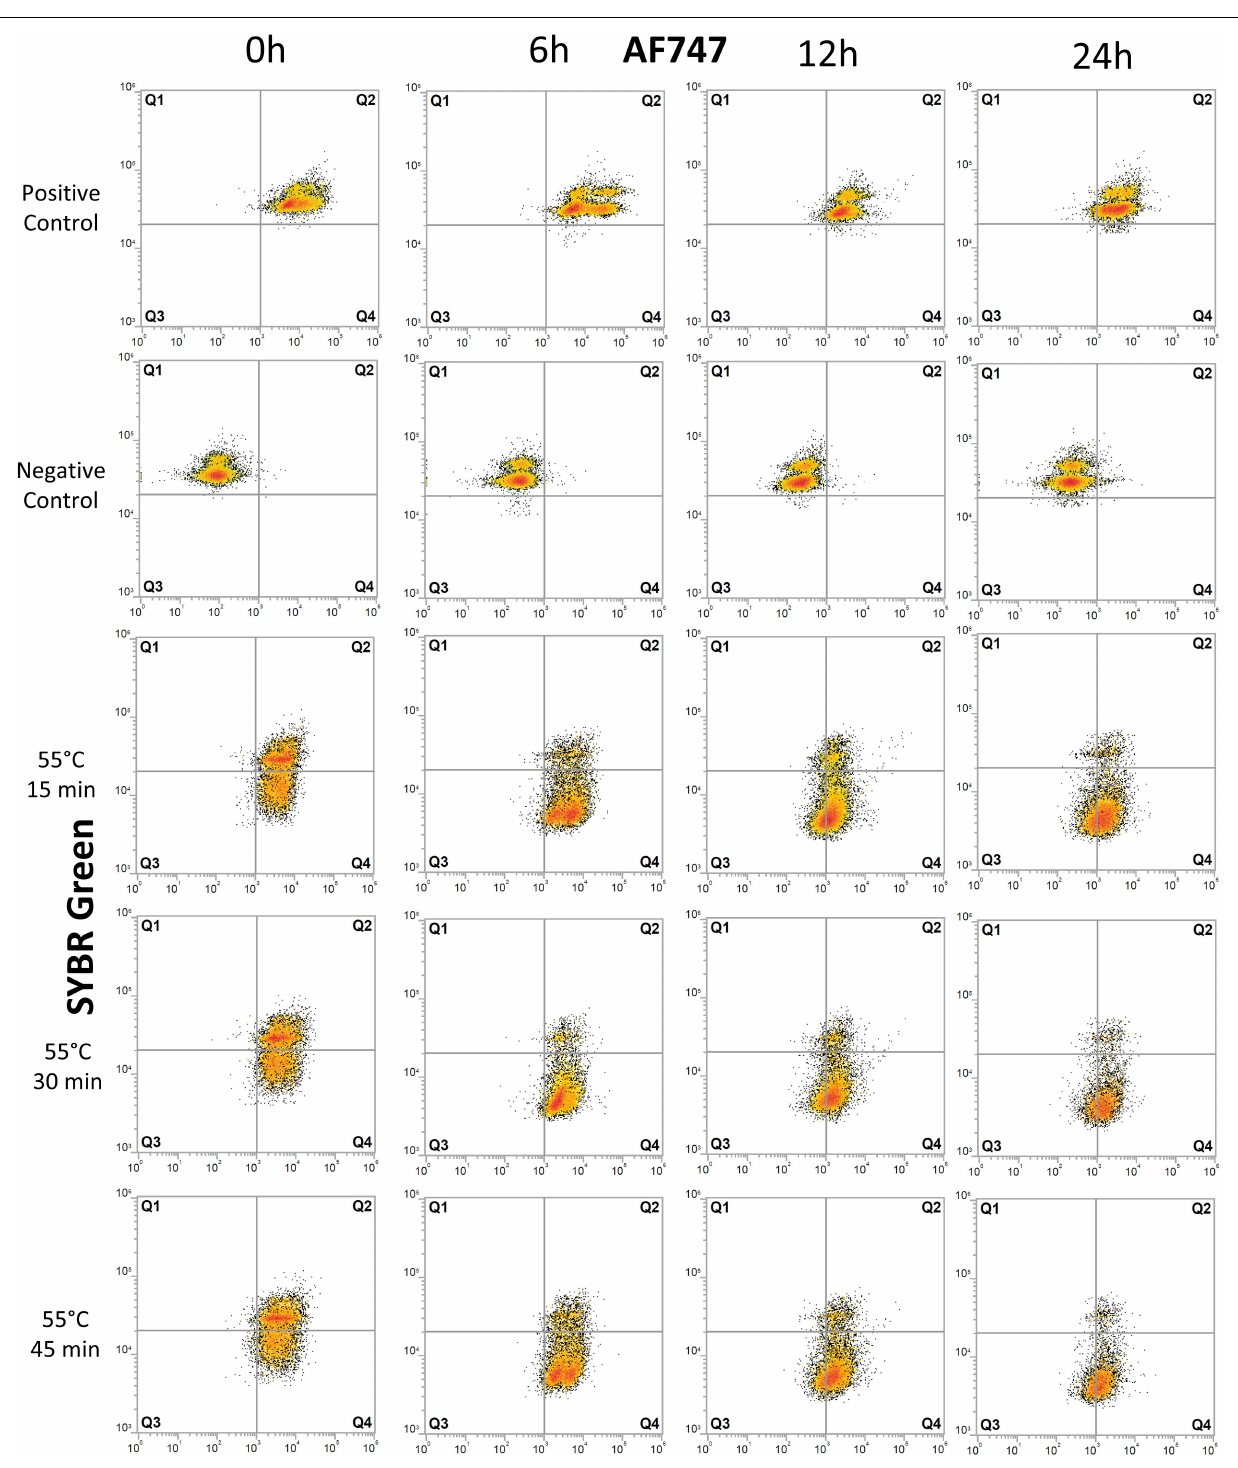
Frontiers in Microbiology |